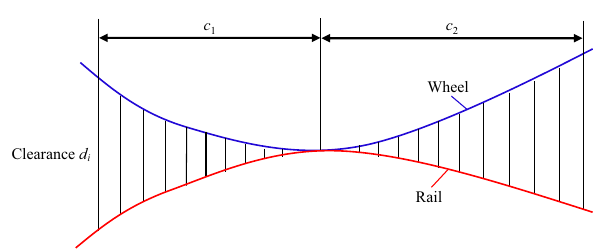
Fig. 4 Normal gap between the wheel and